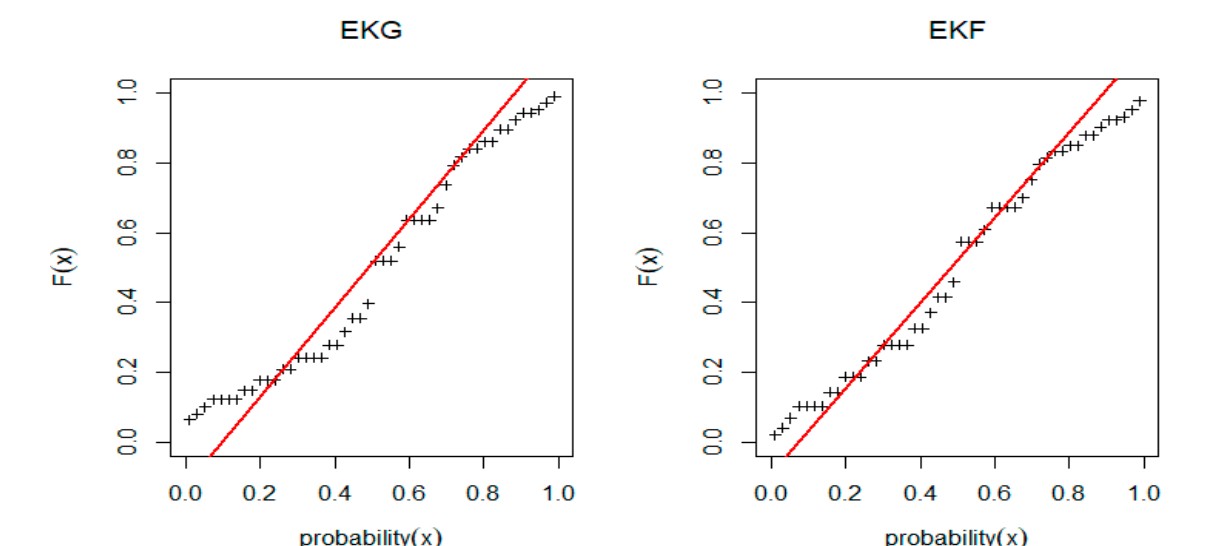
Figure 7. PP-plot for EKG and EGF distribution for Wire data. Table 9. AIC, BIC, CAIC, and HQIC for different sets and different model for Wire data. AIC CAIC BIC